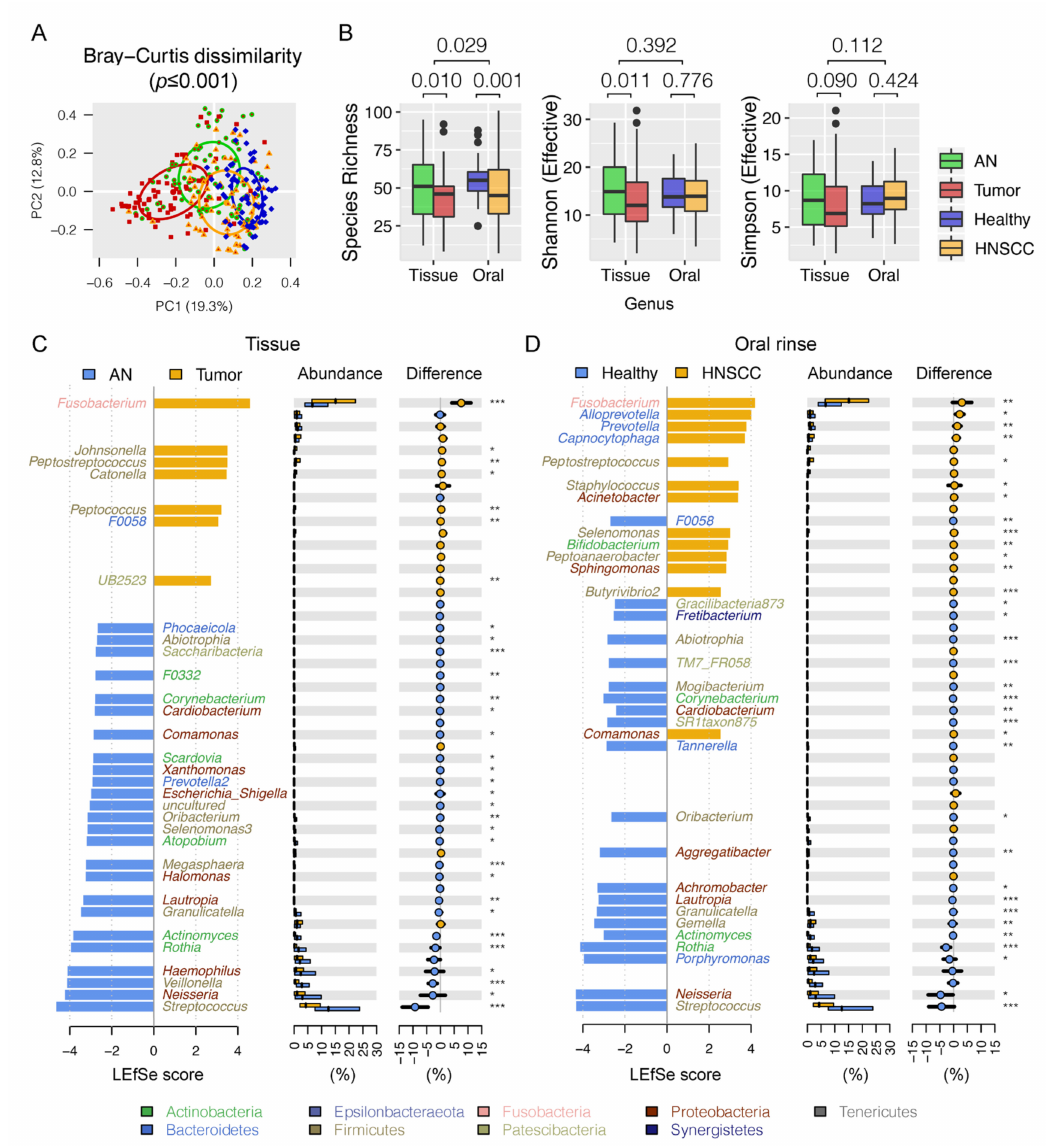
Figure 1. Oral microbiota dysbiosis associated with head and neck squamous cell carcinomas (HNSCCs). ( A ) Principal coordinates plot using Bray–Curtis dissimilarity. ( B ) Comparison of oral microbiota diversity summarized at the genus level. ( C ) Comparison of oral microbiota between HNSCC tumor (tumor) and adjacent normal (AN) tissues, with bacterial genera that best discriminated HNSCCs and controls by a linear discriminant analysis (LDA) for e ff ect size (LEfSe). The bar length represents log10 LDA score. Di ff erence in the relative abundance tested by pairwise Tukey HSD post hoc is shown on the right panel. ( D ) Comparison of oral microbiota between HNSCC oral rinses and healthy